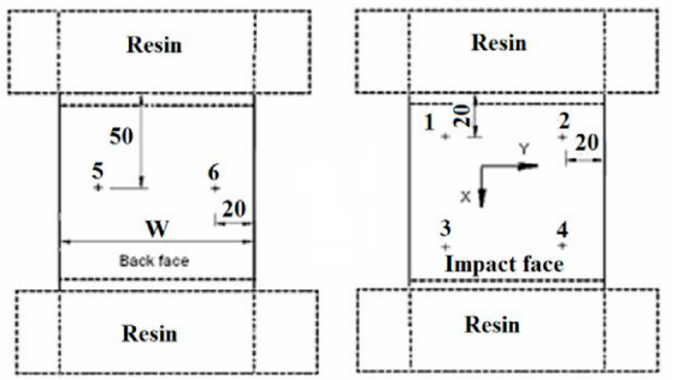
Figure 5. Sandwich specimen gauge length dimensions and strain gauge locations. Resin blocks were used for the [(±45 C ) 2 ,(0 C ,0 G ) 4 ,(±45 C ) 2 ] face specimens. Gauges 1, 2, 3 and 4 were applied on the top face. Gauges 5 and 6 were on the bottom face to ensure that the compression load was applied without inducing any bending. The widths W for the [(±45 C ) 2 ,(0 C ,0 G ) 4 ,(±45 C ) 2 ] and [( ∓ 45 C ) 2 ,(90 C ,90 G ) 4 ,( ∓ 45 C ) 2 ] laminates were 75 mm and 100 mm, respectively (the original impacted specimen was cut shorter for the compression after impact test). The dotted lines show the resin ends in which the speci- mens with [(±45 C ) 2 ,(0 C ,0 G ) 4 ,(±45 C ) 2 ] face laminate are potted to prevent any brooming at the